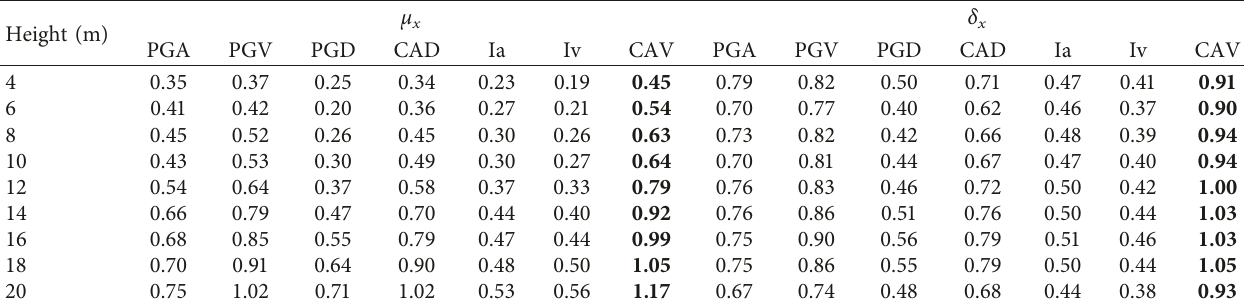
Figure 9: IMs practicality comparison for (a) the bearing deformation along the longitudinal direction and (b) the bearing deformation along the transverse direction. Table 5: Demand models and practicality comparison of IMs subjected to far-field ground